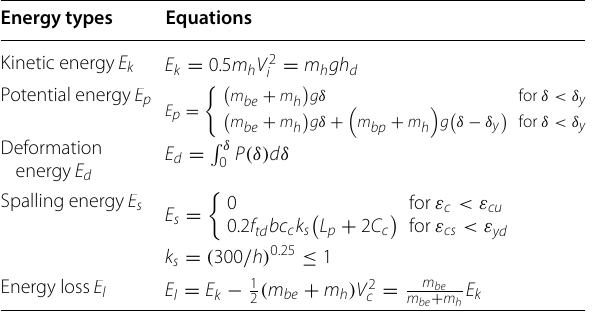
Table 3 Equations of each energy for energy conservation law.